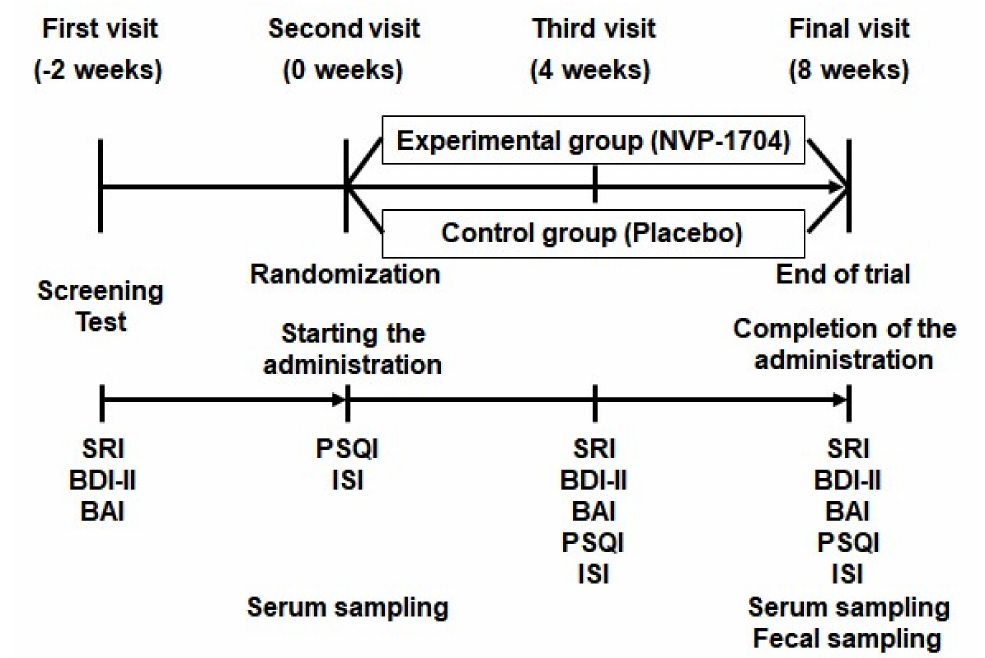
Figure 1. Timeline of the study protocol. SRI, Stress Response Inventory; BDI-II, Beck’s Depression Inventory-II; BAI, Beck’s Anxiety Inventory; PSQI, Pittsburgh Sleep Quality Index; ISI, Insomnia Severity